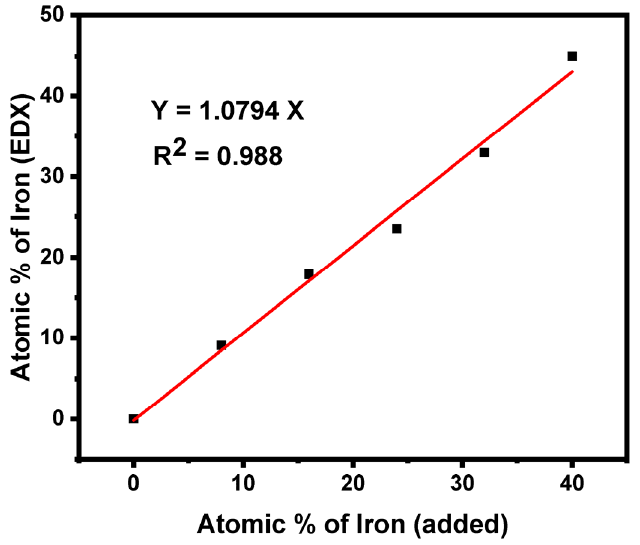
Figure 3. Linear relationship between the amount of iron in the precursors and the amount of iron in Sb 2(1– x ) Fe 2 x S 3 systems determined by energy dispersive X-ray (EDX) measurement. Sb 2(1 − x ) Fe 2 x S 3 systems determined by energy dispersive X-ray (EDX)